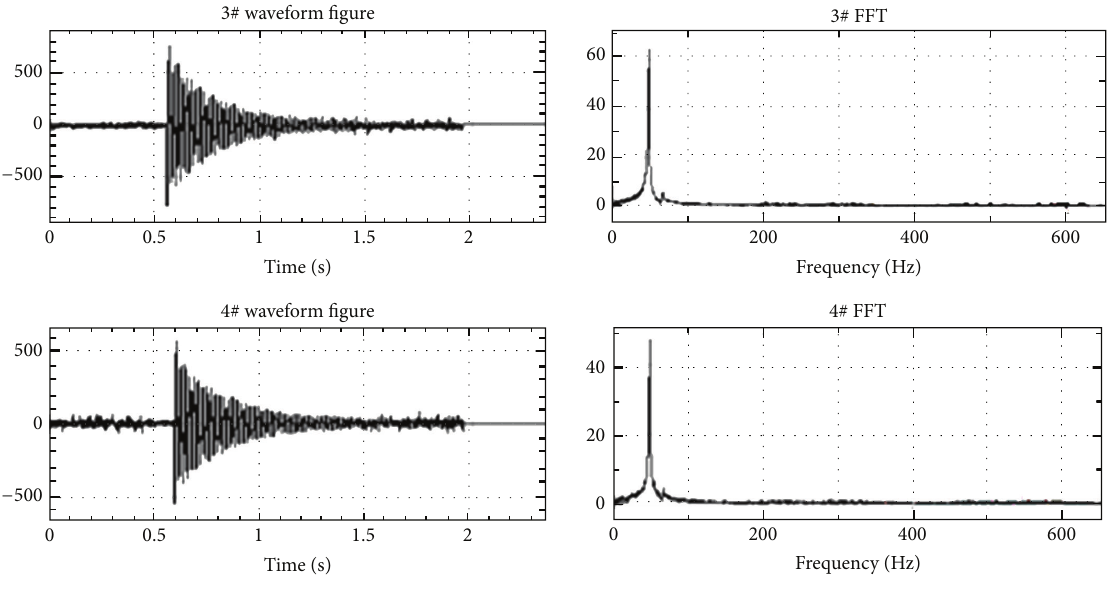
Figure 12: Free vibration curve and spectrogram. Table 11: Extreme and enhanced coefficient of acceleration response (1.5g).